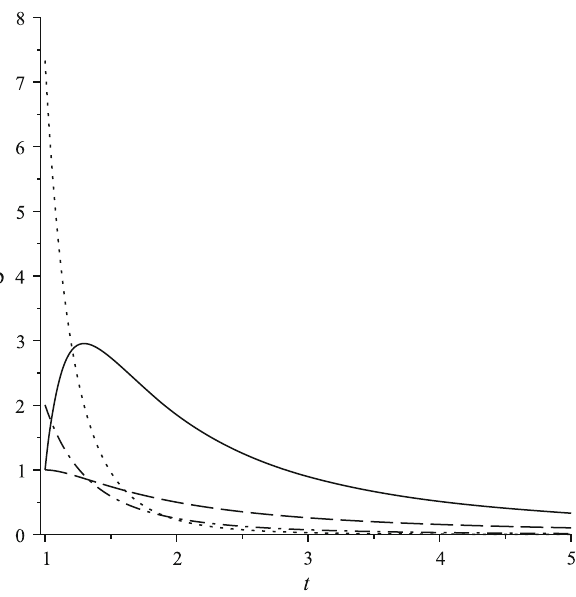
Fig. 1 The figure shows the qualitative behavior of energy densities of dark matter (dotted and dash-dotted lines for − 1 < ω << − 1 / 3 and ω (cid:2) − 1 / 3 respectively) and holographic dark energy (solid and dashed lines for − 1 < ω << − 1 / 3 and ω (cid:2) − 1 / 3 respectively). We see that at t 0 the expansion is dominated by dark matter, and at some t > t 0 the holographic dark energy begins dominate